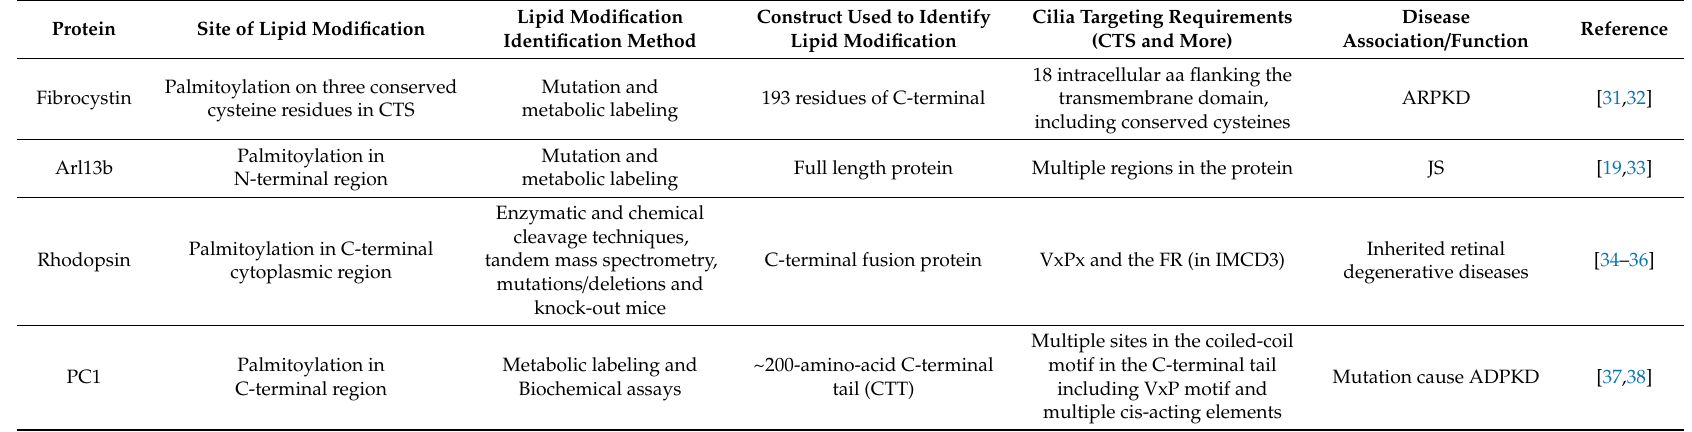
Table 2. List of lipid-modified ciliary and flagellar proteins discussed in this review.